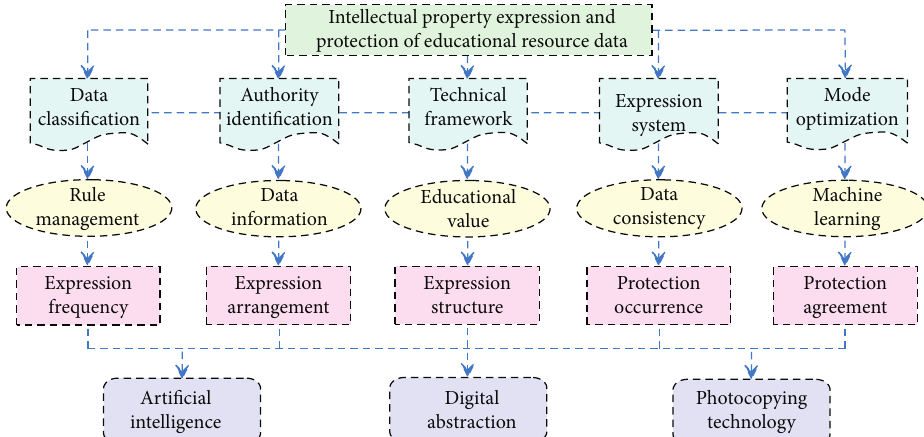
Figure 1: Framework for intellectual property expression and protection of educational resource data based on machine